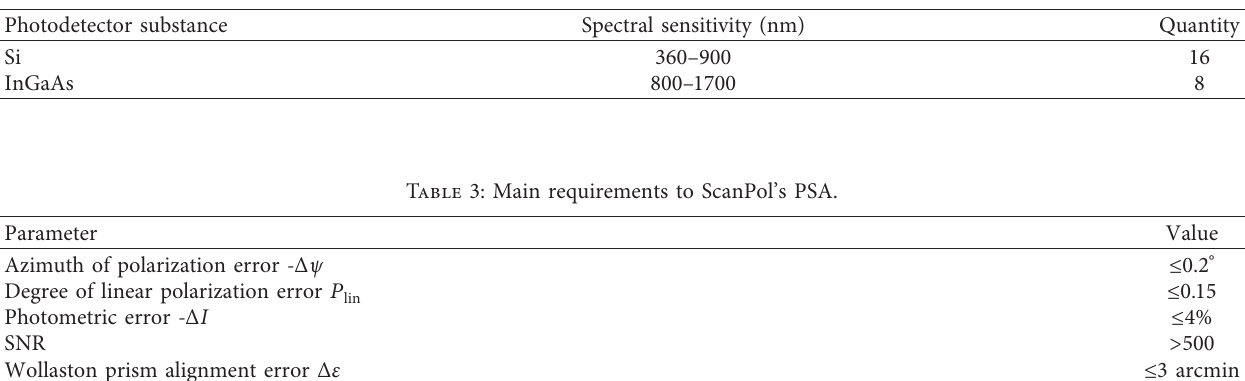
Table 2: ScanPol photodetectors.